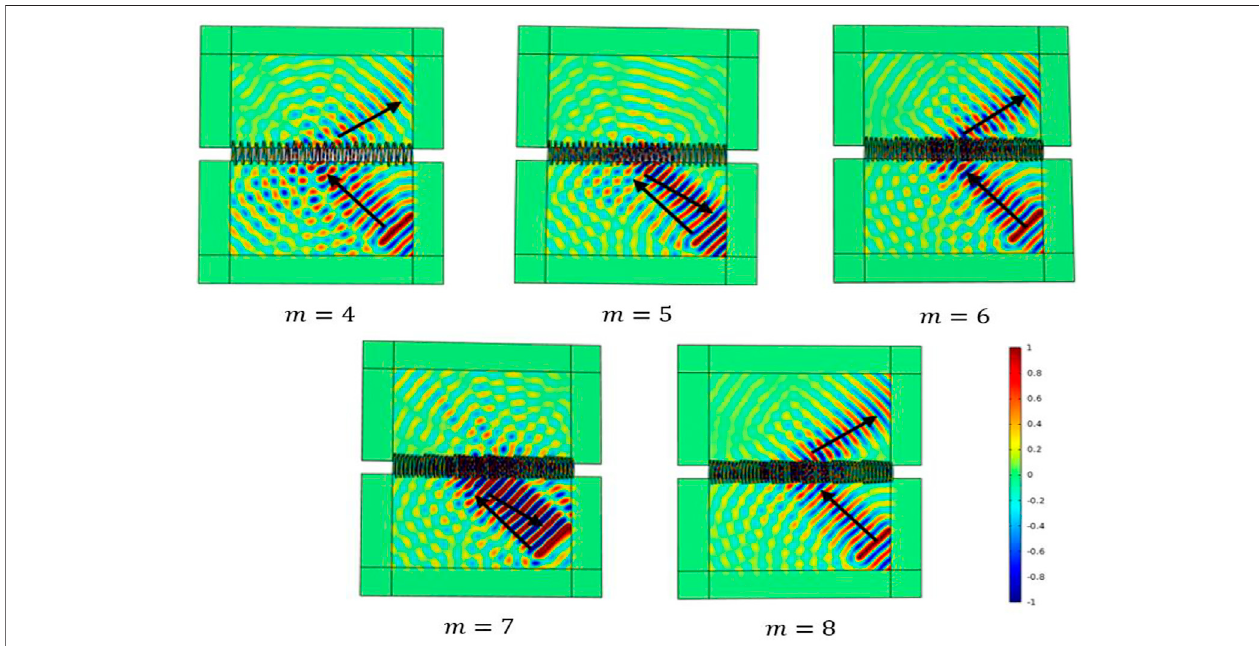
FIGURE 7 | When L (cid:2) 2 λ 1 , the incident wave angle is 45 ° , the corresponding transmitted wave fi elds of metasurfaces with different unit cell numbers.